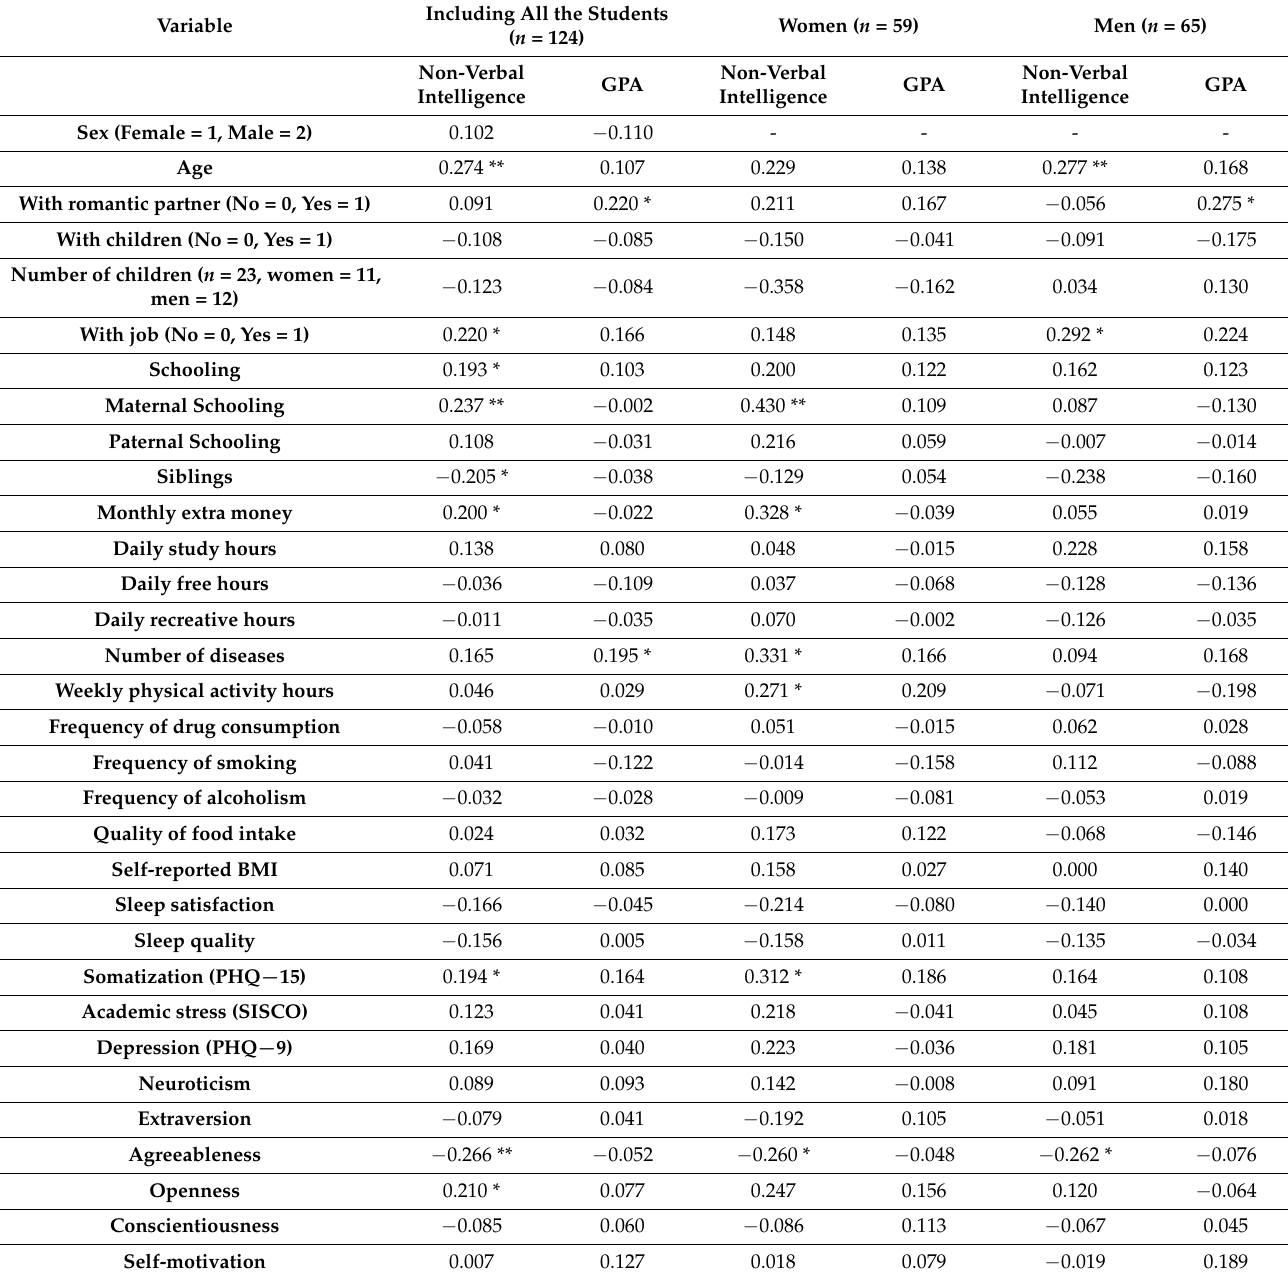
Table 2. Correlations of studied variables with non-verbal intelligence and